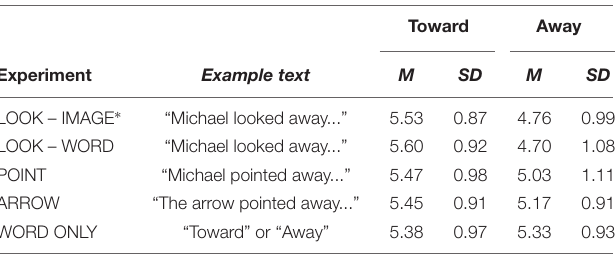
TABLE 2 | Mean liking ratings as a function of group (LOOK – IMAGE, LOOK – WORD, POINT, ARROW, and WORD ONLY) and cue direction (toward and away). Toward